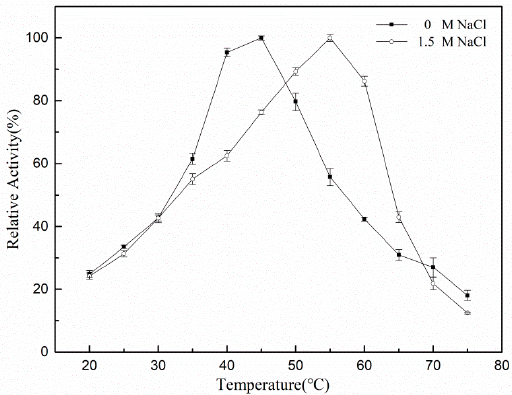
Figure 4. The influences of temperature on the activity of the Xyl88.